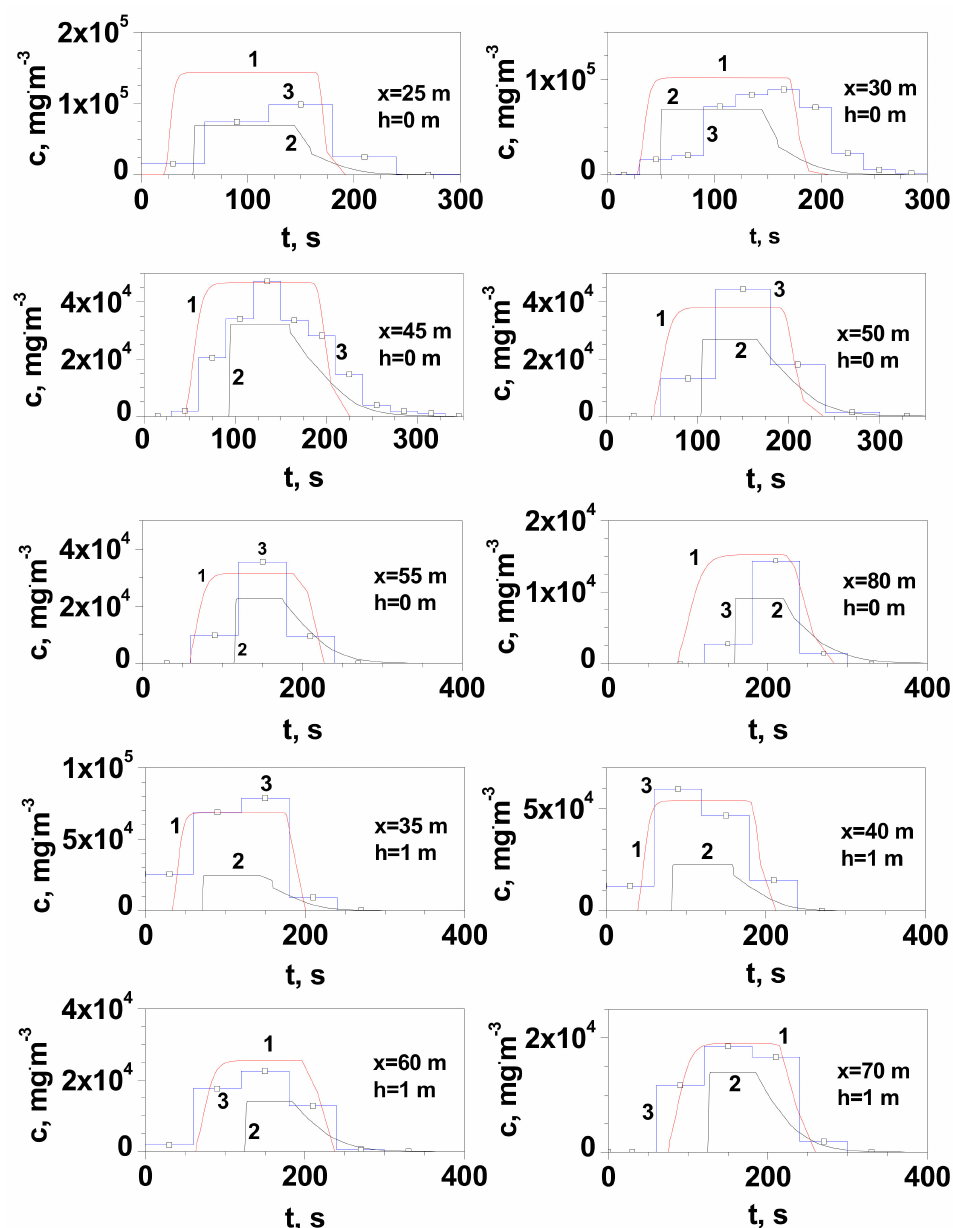
Figure 5. Comparison of the concentration dependence as a function of time for the Gaussian gas model ( 1 ) and the dense gas model ( 2 ) against the obtained experimental data ( 3 ) at height (h) and at distance (x) from the release location in the wind blowing direction. Atmospheric conditions of the measurement series 2: T = 20.1 ◦ C, v = 0.73 m/s, RH = 44%, p = 1002.8 hPa. Release parameters: Q = 1.72 kg/s, p out = 6 atm, t = 144 s, h = 0.75